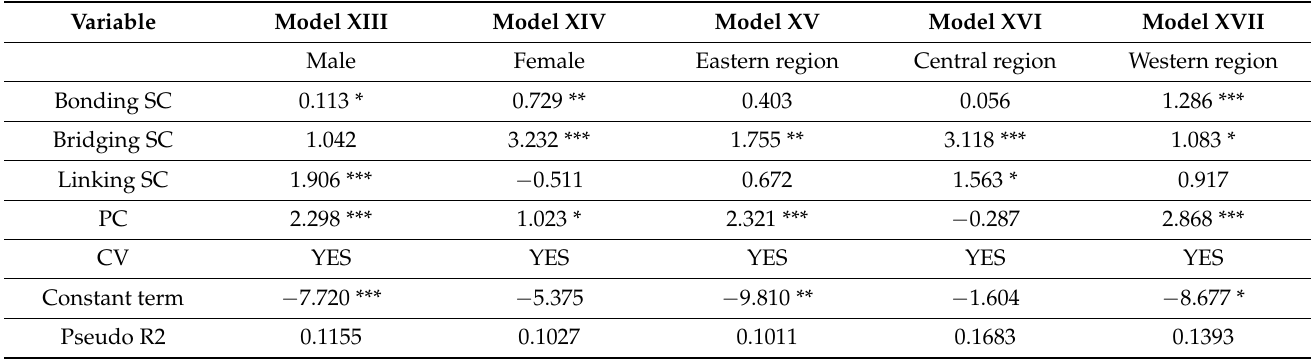
Table 9. Heterogeneity verification